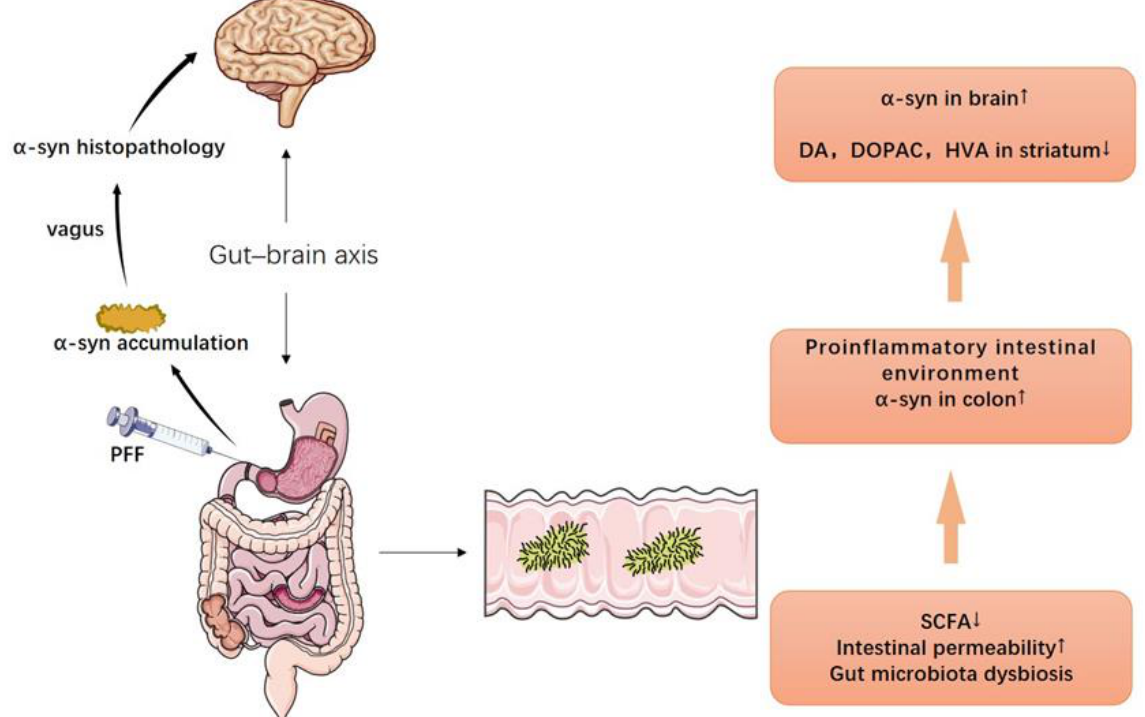
Figure 1. The gut–brain axis and the PD model of PFF. Injection of α -synuclein preformed fibers (PFFs) into duodenum and gastric pylorus induces α -synuclein aggregates’ formation in the dorsal motor nucleus of the vagus (DMV) and locus coeruleus, which eventually travel to the brain via the vagus nerve (the left half). Decreased SCFAs in gut, increased intestinal permeability, and intestinal microbiota imbalance cause a proinflammatory intestinal environment and α -synuclein aggregation, which ultimately lead to an increase in α -synuclein and a decrease in dopamine and dopaminergic metabolites (DOPAC, HVA) in the brain (the right